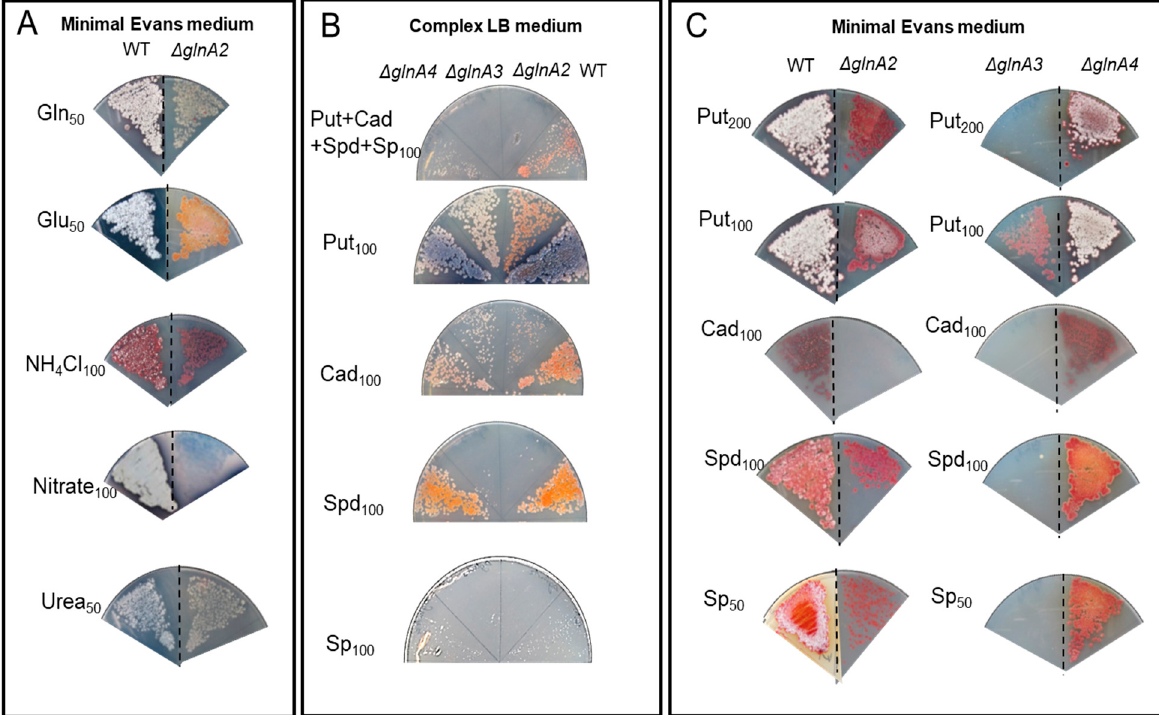
Figure 6. Growth of S. coelicolor M145 as well as glnA2 , glnA3 , and glnA4 mutants on polyamine containing media. ( A ) Phenotypic analysis of strains on the rich LB-medium in the presence of 100 mM putrescine (Put), cadaverine (Cad), spermidine (Spd), and spermine (Sp) or polyamine mixture (25 mM each). ( B ) Phenotypic analysis of strains on defined Evans medium with glutamine (50 mM) (Gln), glutamate (50 mM) (Glu), ammonium (100 mM) (NH 4 Cl), nitrate (100 mM), urea (50 mM). ( C ) Phenotypic analysis of strains on defined Evans medium with putrescine (100 mM), cadaverine (100 mM), spermidine (100 mM), and spermine (50 mM). Each panel represents observations on a single agar plate; observations on separate agar plates are indicated by the dashed line.